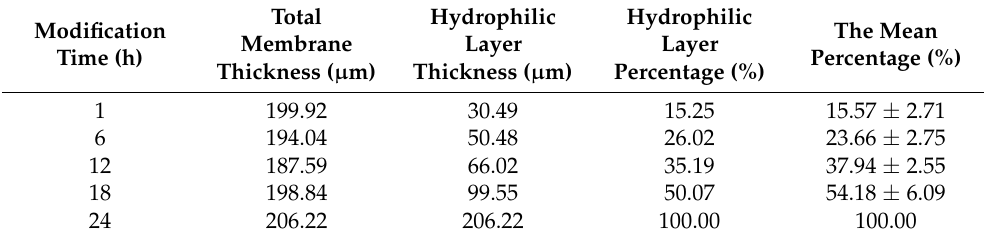
Table 4. Variation trend of hydrophilic layer thickness of Janus